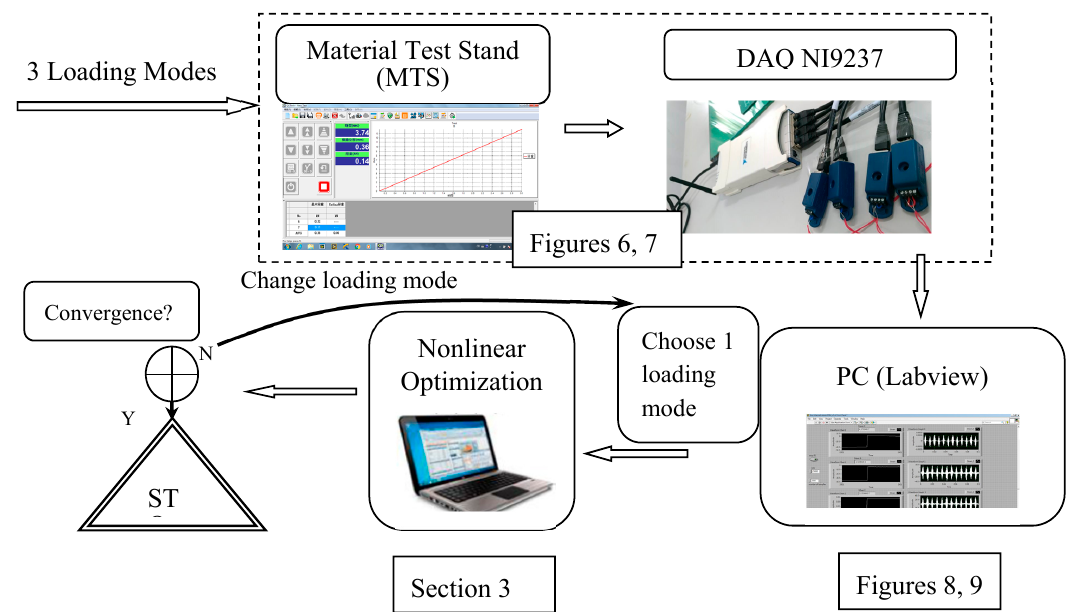
Figure 5. Hardware-in-the-loop simulation of hole/crack identification by using measured strains. Step 1: